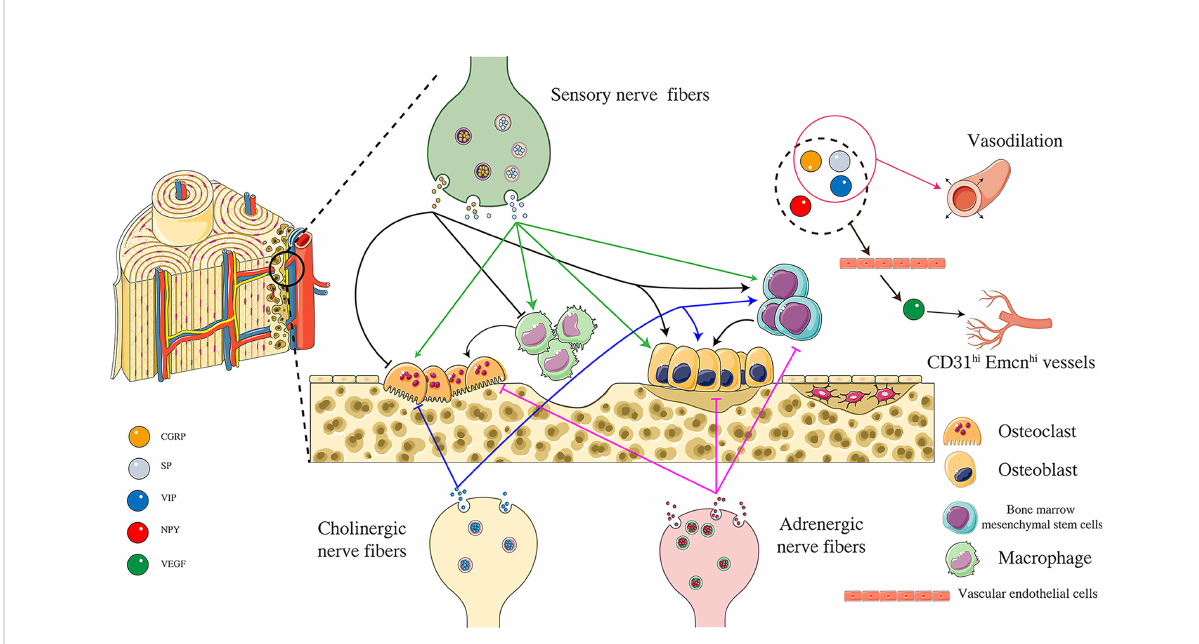
FIGURE 2 Effects of different neuropeptides on “ Angiogenesis-Osteoclast-Osteogenesis ” . CGRP released from peripheral sensory nerve endings can inhibit the activity of osteoclasts and inhibit the differentiation of macrophages to osteoclasts by acting on CGRP receptors. At the same time, CGRP can promote the activity of osteoblasts and the osteogenic differentiation of bone marrow mesenchymal stem cells. SP is another neuropeptide released from sensory nerve endings, promoting the differentiation of macrophages into osteoclasts and improving osteoclast activity by acting on NK1 receptors. SP can also promote osteoblast activity and bone marrow mesenchymal osteogenic differentiation of stem cells. NPY is released from adrenergic nerve endings. NPY is released from adrenergic nerve endings, and NPY acts on peripheral Y1 receptors to inhibit osteoblast activity, osteogenic differentiation of bone marrow mesenchymal stem cells, and osteoclast activity. VIP is released from acetylcholinergic nerve endings, inhibits osteoclast activity by binding to VPAC1 receptor, and can also promote osteoblast activity by binding to VPAC2 receptor. VIP also promotes osteogenic differentiation of bone marrow mesenchymal stem cells. CGRP, SP, NPY, VIP can promote VEGF production indirectly promote the formation of CD31 hi Emcn hi blood vessels. In addition, CGRP, SP, and VIP have the effect of vasodilation. Figure 2 was modi fi ed from Servier Medical Art(http://smart.servier.com/), licensed under a Creative Common Attribution 3.0 Generic License.